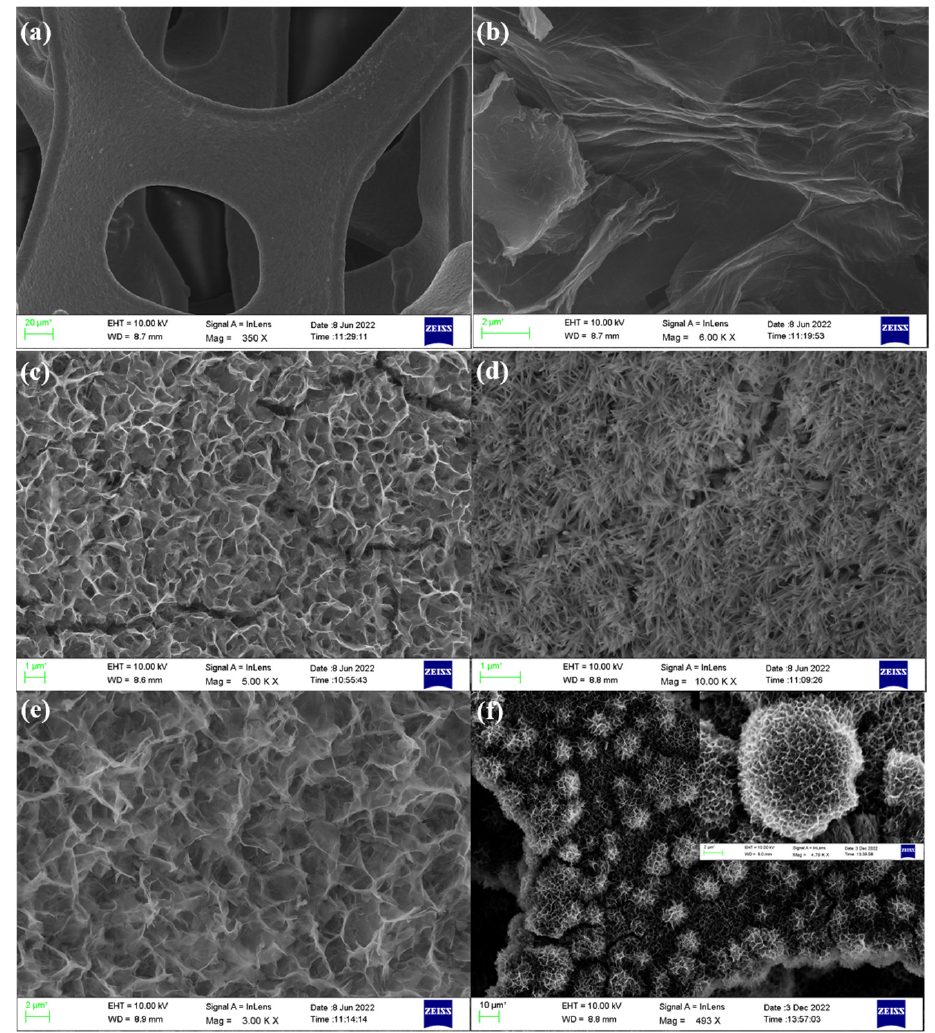
Figure 4. SEM images of ( a ) bare NF, ( b ) rGO/NF, ( c ) Nd 2 O 3 /rGO/NF, ( d ) Co 3 O 4 /rGO/NF, ( e ) Nd 2 O 3 /Co 3 O 4 /NF, and ( f ) Nd 2 O 3 /Co 3 O 4 /rGO/NF; the inset in ( f ) is the plot of Nd 2 O 3 /Co 3 O 4 /rGO/NF magnification.